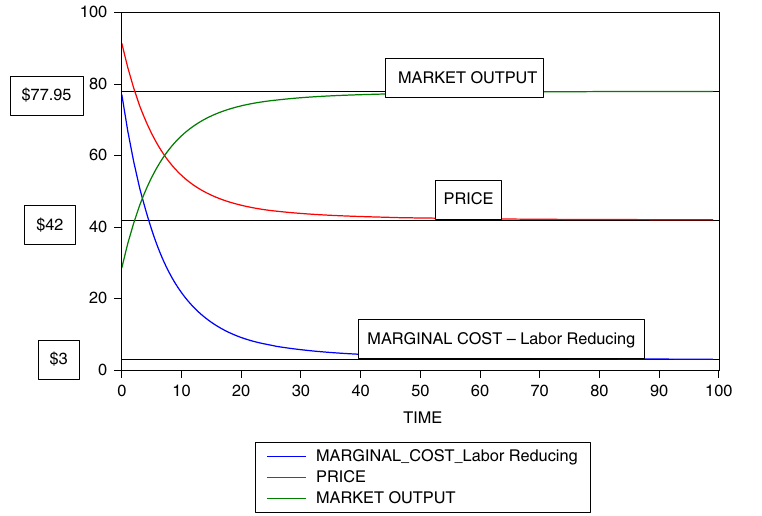
Figure 3. The market outcomes in the long run: labor- reducing technology